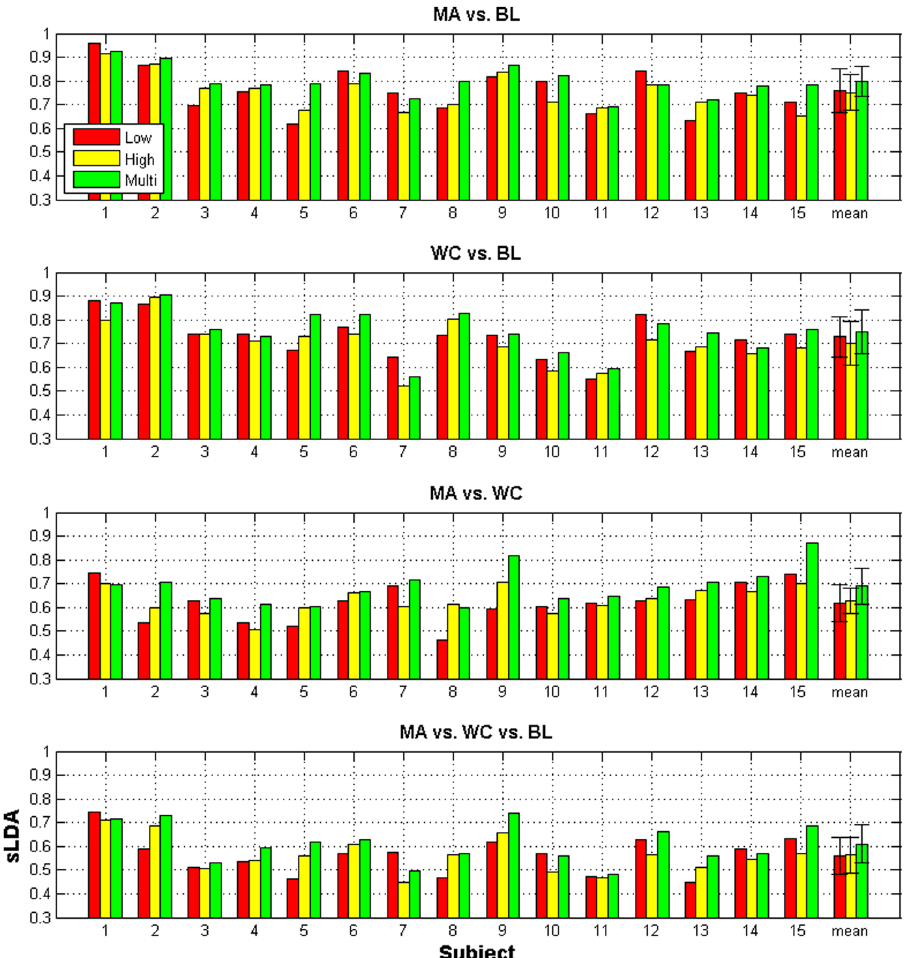
Figure 7. Comparison of binary and ternary classification accuracies for the lattice arrangement of the 30 mm SD separation (denoted by Low), high-density 30 mm SD separation (denoted by High), and combined multi-distance SD separations (denoted by Multi). The highest classification accuracy occurs among the classification accuracies of all possible multi-distance SD separations. The error bar indicates the standard